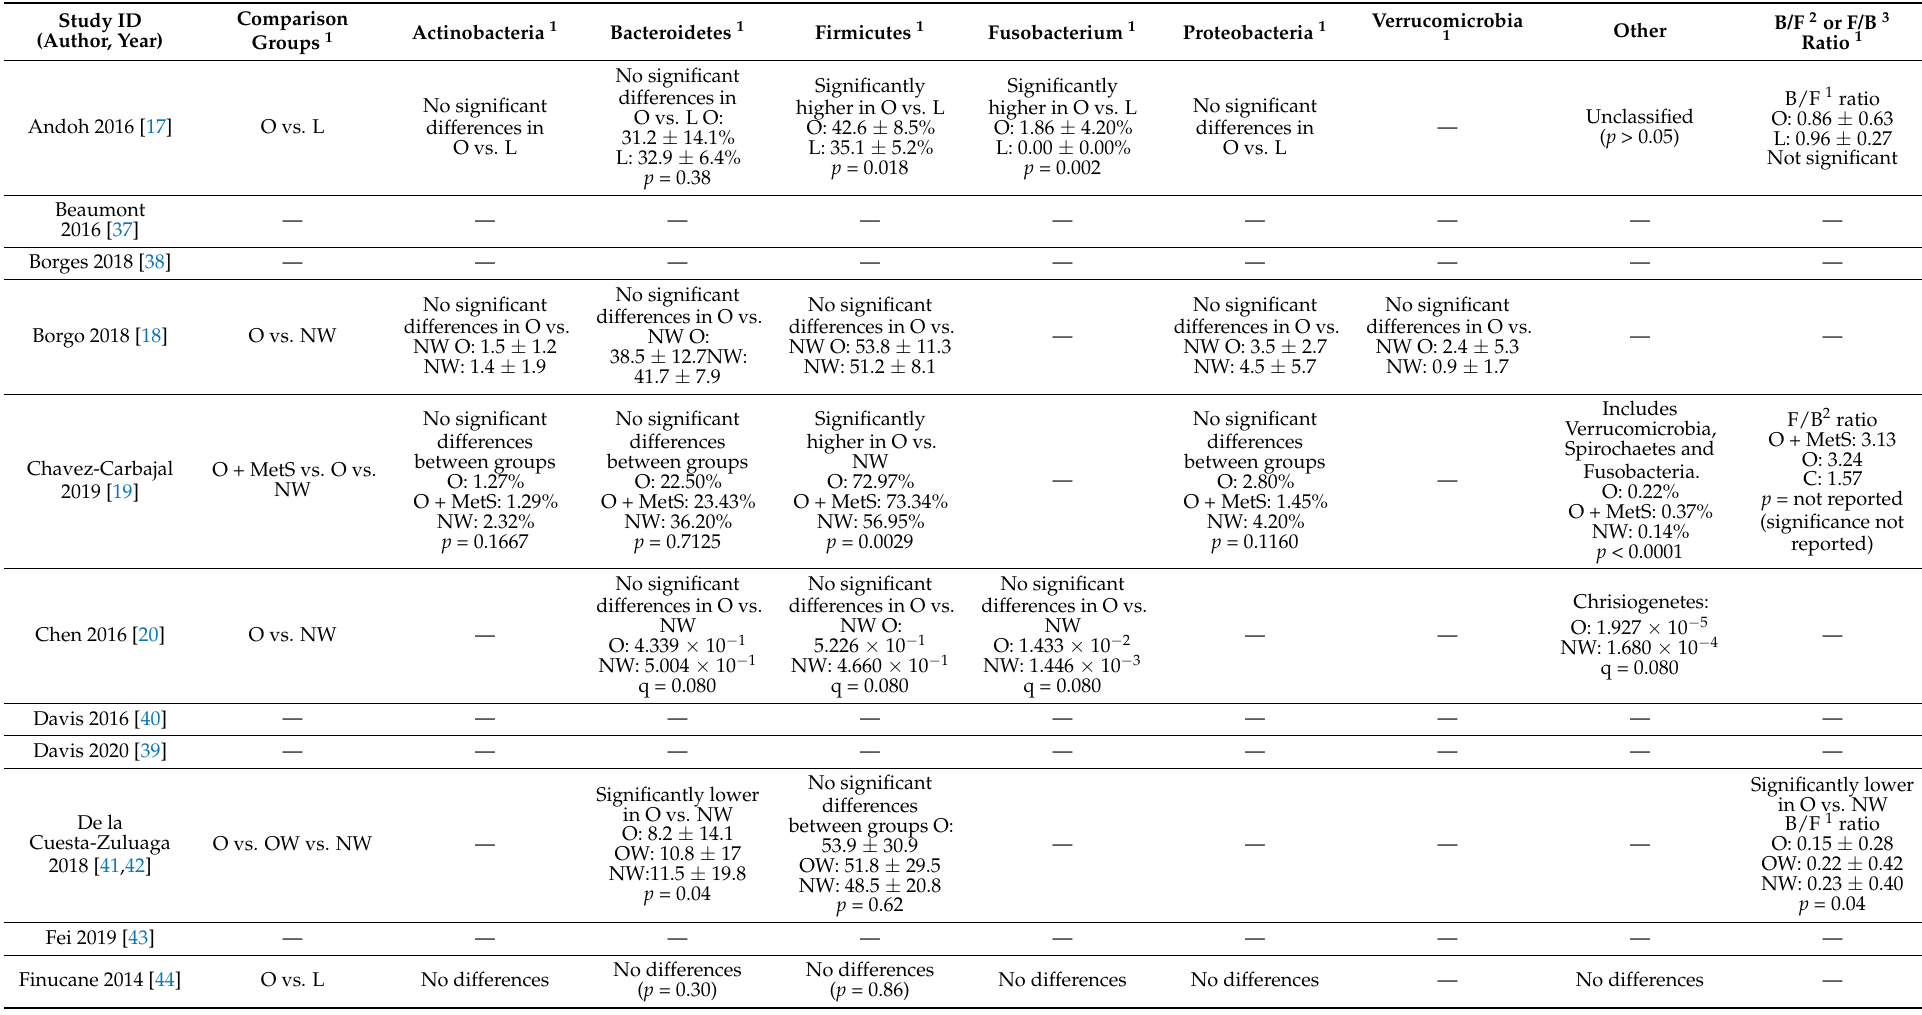
Table 3. Differences in the relative abundance of bacteria at phylum